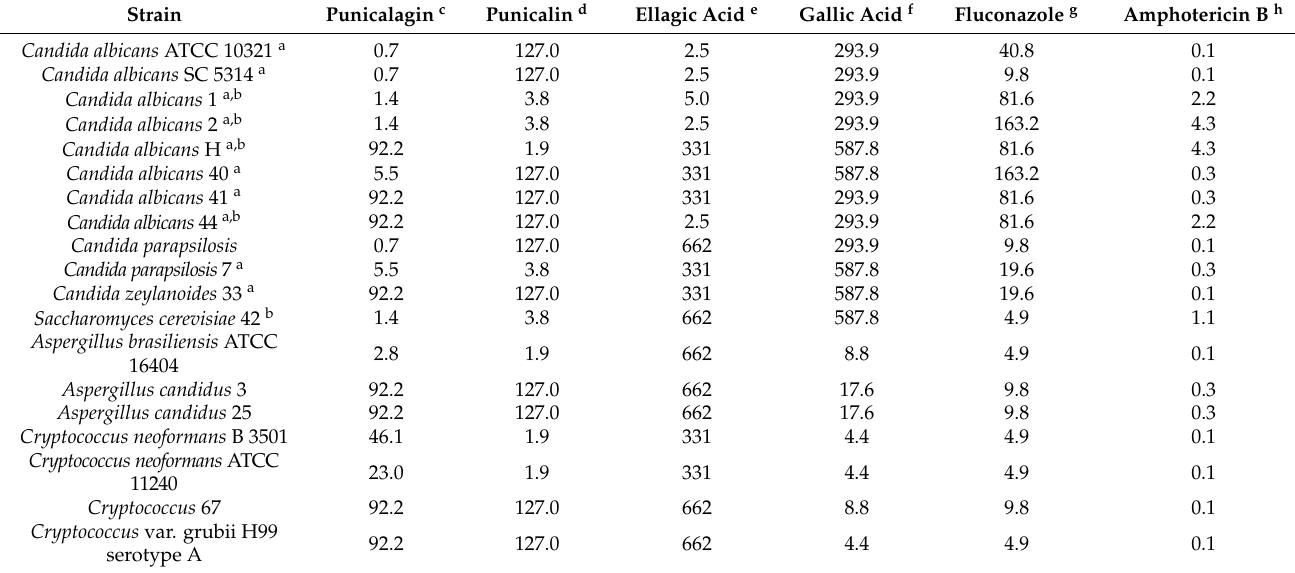
Table 2. Minimum inhibitory concentration (MIC) of punicalagin, punicalin, ellagic acid, gallic acid, fluconazole, and amphotericin B (antifugal positive controls). Data are expressed as µ